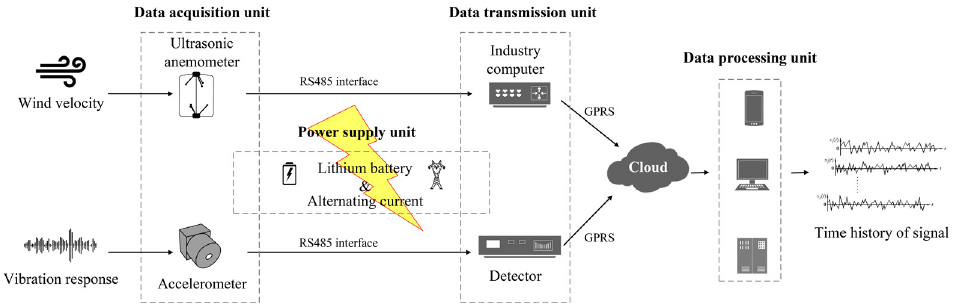
Figure 2. Architecture of the wireless monitoring system.